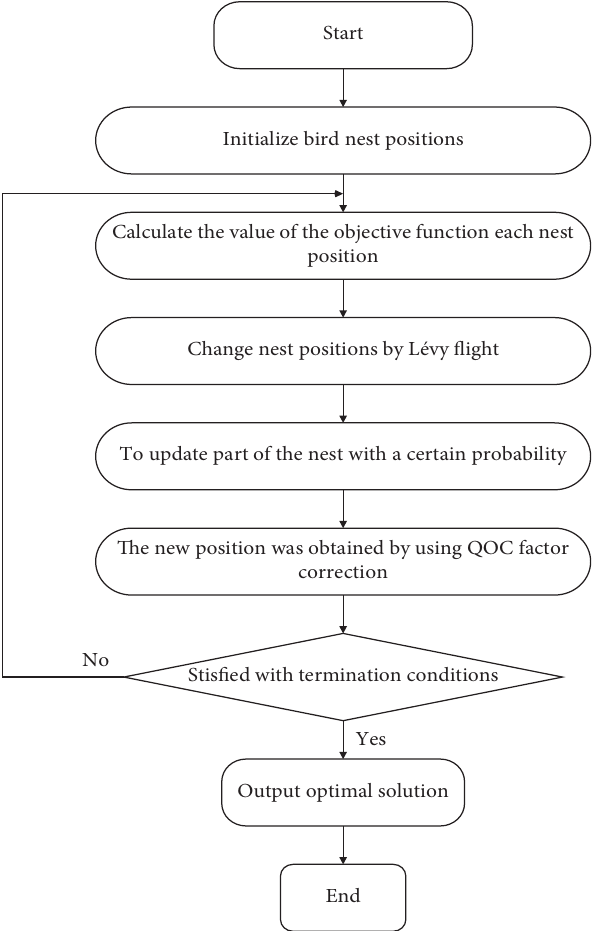
Figure 2: Flowchart of modified cuckoo